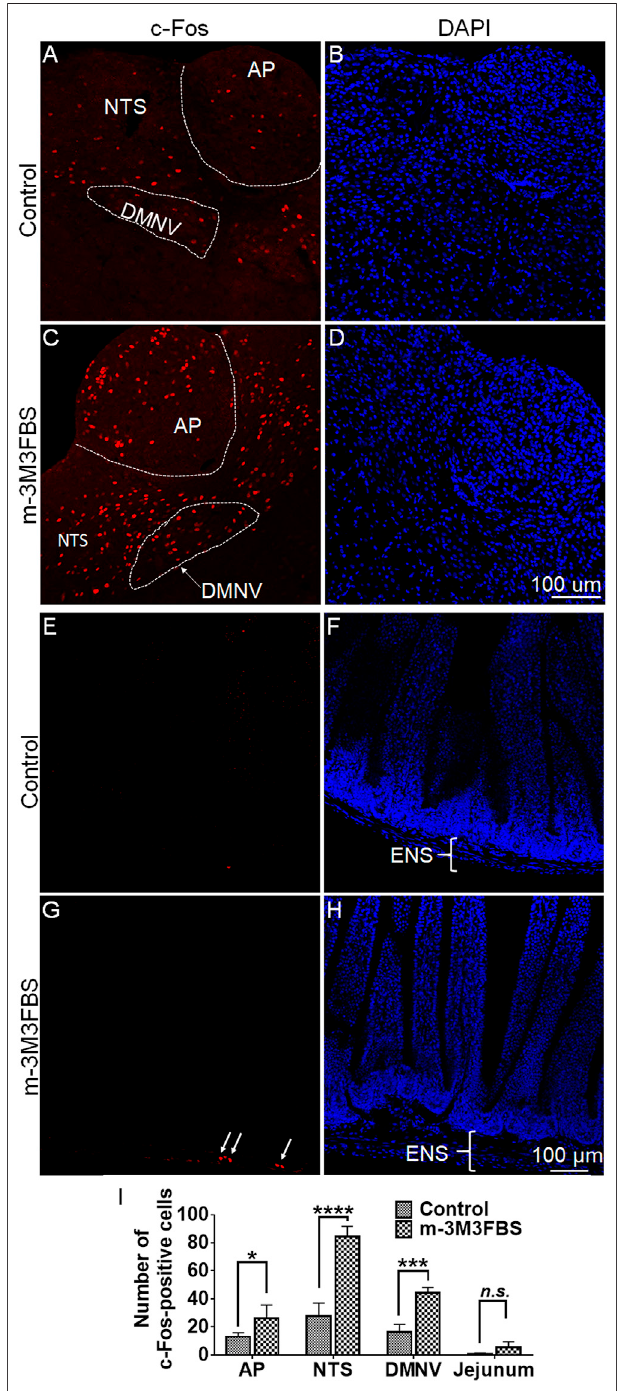
FIGURE 2 | Immunohistochemical analysis of c-Fos expression following m-3M3FBS-induced emesis. Least shrews were sacri fi ced 90 min post vehicle treatment, or after the fi rst vomiting occurred post systemic administration (50 mg/kg, i. p.) of m-3M3FBS ( n (cid:1) 3 shrews per group). Shrew brainstem sections (20 μ m) and jejunal sections (25 μ m) were stained with rabbit c-Fos antibody and Alexa Fluor 594 donkey anti-rabbit secondary antibody. (A,C) Representative images show that compared to the vehicle- treated control group, signi fi cant c-Fos expression evoked by m-3M3FBS